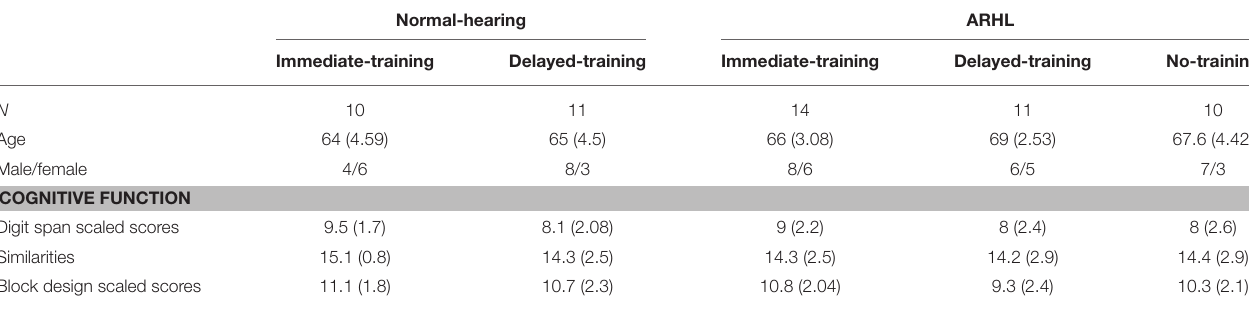
TABLE 1 | Means and (SDs) of demographic and cognitive measures across all groups (immediate-training, delayed-training, and no-training) divided into normal-hearing (NH) and Age-related hearing loss (ARHL) groups.